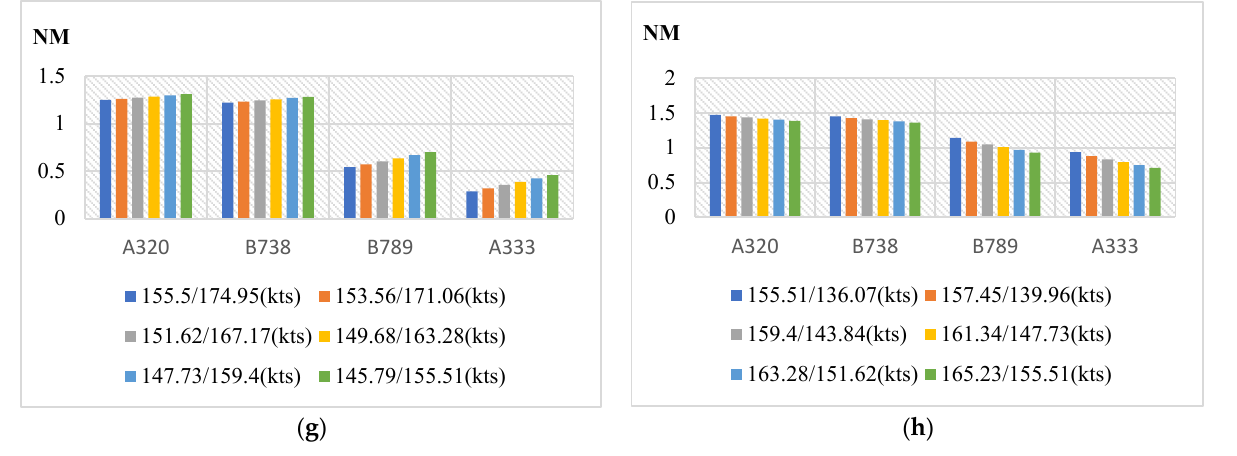
Figure 5. Reduction in required flight separation with respect to ICAO standard at different aircraft velocities. (The legend is “velocity of leading aircraft/velocity of following aircraft”). ( a ) Case 1, deceleration is − 2 m/s 2 . ( b ) Case 2, acceleration is 2 m/s 2 . ( c ) Case 3, deceleration is − 2 m/s 2 . ( d ) Case 4, acceleration is 2 m/s 2 . ( e ) Case 5, front deceleration is − 2 m/s 2 , following deceleration is − 1 m/s 2 . ( f ) Case 6, front acceleration is 2 m/s 2 , following acceleration is 1 m/s 2 . ( g ) Case 7, front deceleration is − 1 m/s 2 , following deceleration is − 2 m/s 2 . ( h ) Case 8, front acceleration is 1 m/s 2 , following acceleration is 2 m/s 2 .